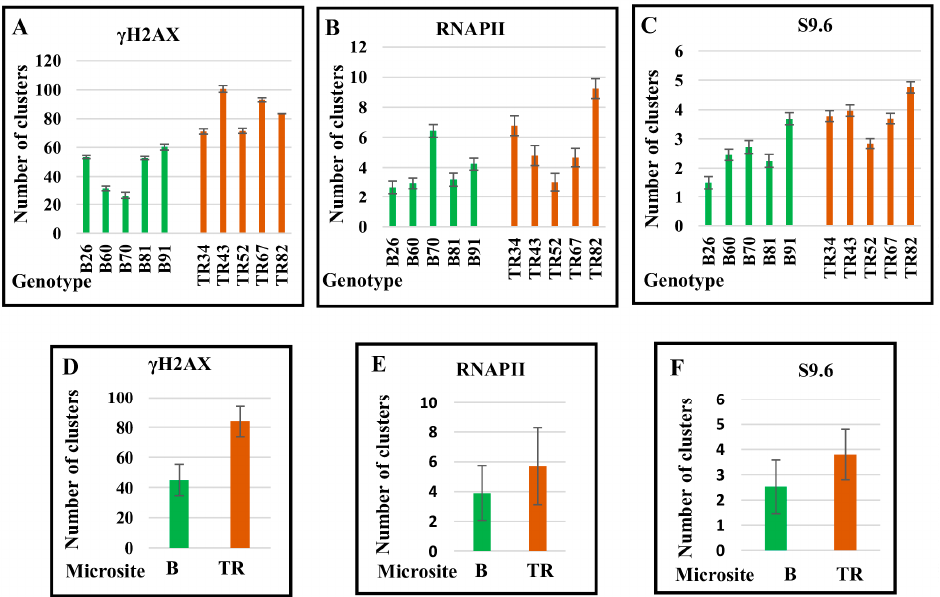
Figure 7. Immunodetection of clusters of RNAPII, S9.6, and γ H2AX in interphase nuclei; genotype TR34. ( A ) Counterstaining with DAPI. Immunofluorescent localization of ( B ) anti-RNAPII Alexa Fluor ® 546-conjugated antibody (in yellow); ( C ) anti-DNA-RNA hybrid [S9.6] FluoroProbes ® 647-conjugated antibody (in red); ( D ) anti- γ H2AX antibody; anti-rabbit Alexa Fluor ® 488-conjugated secondary antibody (in green). ( E ) Merged image. The co-localization of RNAPII, S9.6, and γ H2AX large clusters is indicated with arrows. Bar represents 10 µm. Table 2. Mean number of γ H2AX, RNAPII, and S9.6 clusters in interphase nuclei in plants of the Basalt (B) and Terra Rossa (TR) microsites of the Tabigha population.